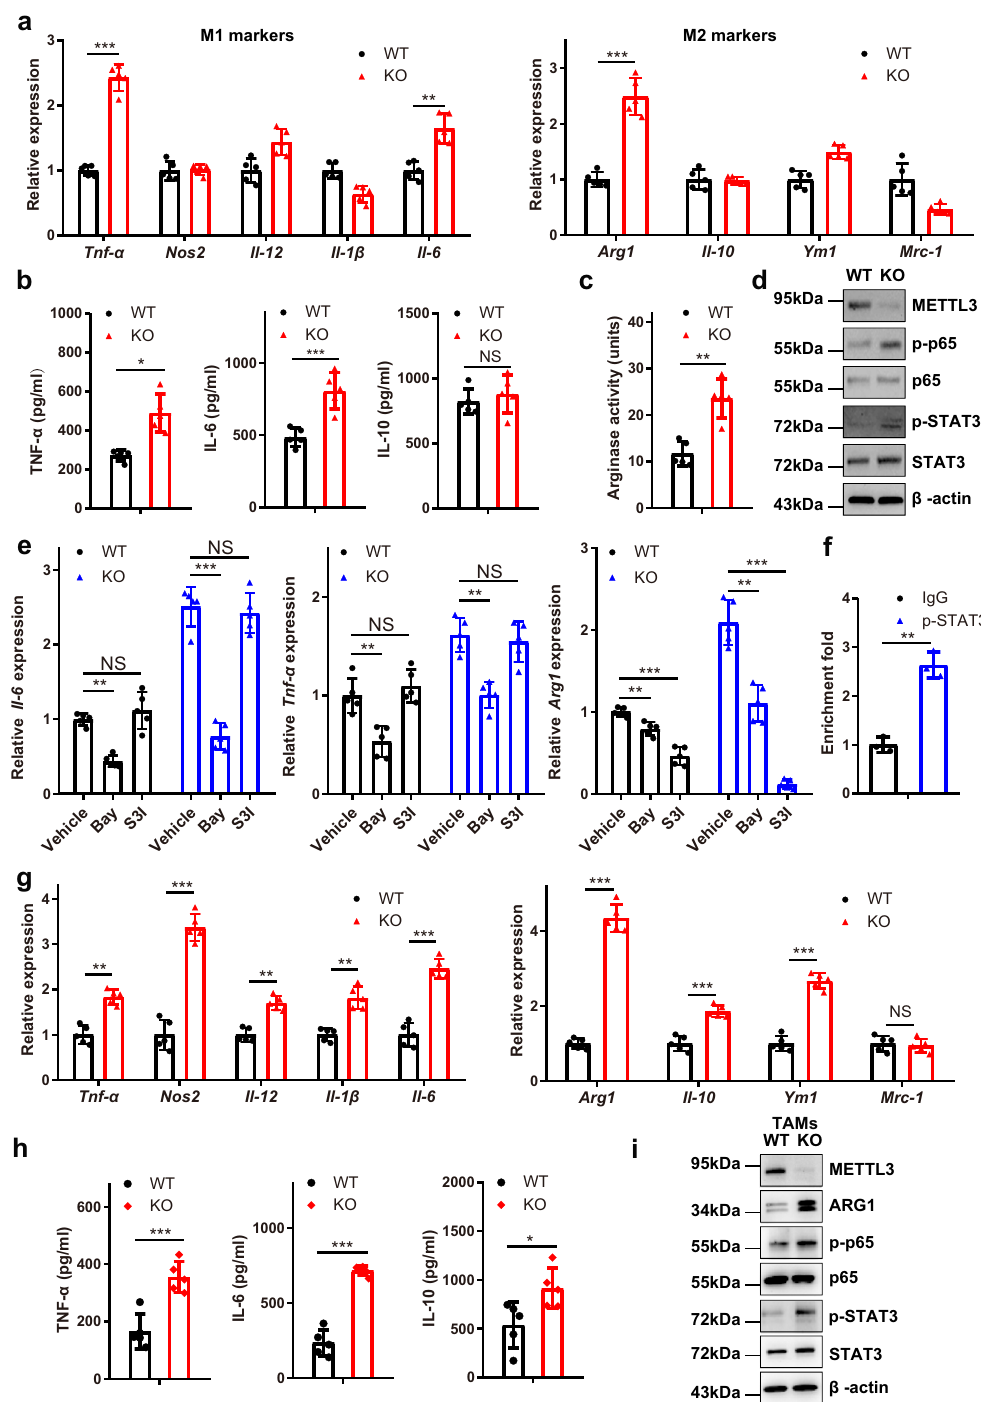
Fig. 4 Mettl3 depletion facilitates the M1 and M2 polarization of BMDMs through NF-kB/STAT3. a qRT-PCR analysis of M1 and M2 macrophage- associated gene expression in WT and KO BMDMs ( n = 5 mice per group). b ELISA analysis of TNF- α , IL-6 and IL-10 secretion by WT and KO BMDMs ( n = 5 mice per group). c Arginase activity in WT and KO BMDMs ( n = 5 mice per group). d Western blot analysis of p65, p-p65, STAT3 and p-STAT3 in WT and KO BMDMs. The blots are representative of n = 3 independent experiments. e qRT-PCR analysis of Tnf- α , Il-6 and Arg1 in WT and KO BMDMs treated with the NF- κ B inhibitor BAY-11-7082 (5 µ M) or STAT3 inhibitor S3I-201 (100 µ M) for 8 h ( n = 5 mice per group). f A ChIP assay was performed with an anti-p-STAT3 antibody, followed by PCR ampli fi cation of the Arg1 promoter. n = 3 independent experiments. g WT and KO TAMs were isolated from tumour-bearing mice. M1 and M2 macrophage-associated gene expression was assessed by qRT-PCR ( n = 5 mice per group). h The expression of TNF- α , IL-6 and IL-10 in TAMs isolated from B16 tumour-bearing mice was analysed by ELISA ( n = 5 mice per group). i The expression of ARG1, p65, p- p65, STAT3 and p-STAT3 in TAMs was determined by immunoblotting. The blots are representative of n = 3 independent experiments. Data are shown as the mean ± SD. P values were determined by a two-tailed t -test ( a – c and e – h ). * P ≤ 0.05, ** P < 0.01 and *** P < 0.001. NS (non-signi fi cant) means P > 0.05. The source data are provided as a Source data fi